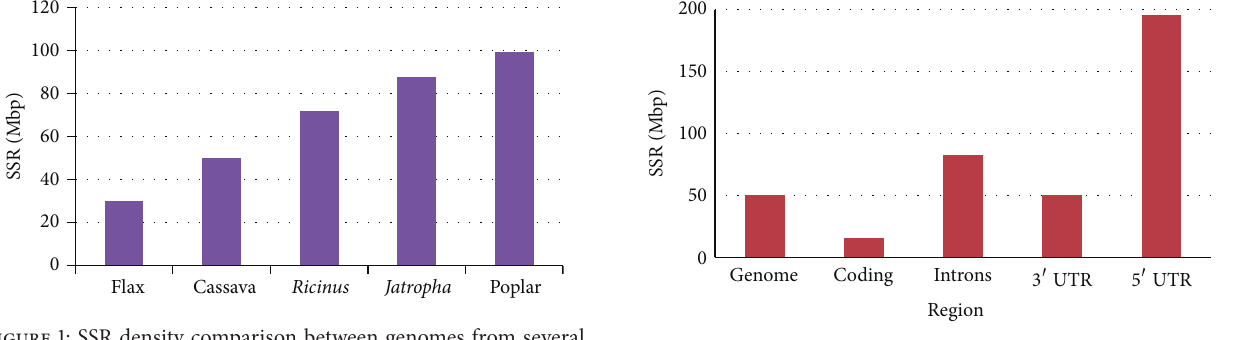
Figure 3: SSR density in different cassava genome